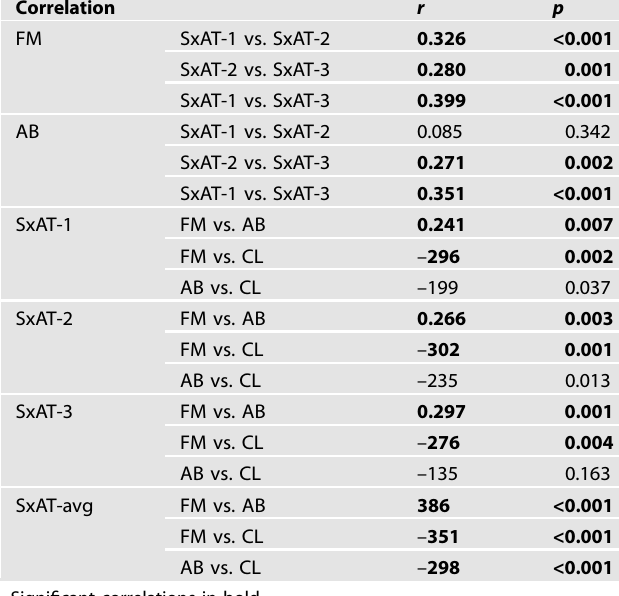
Table 1. Overview of Pearson ’ s correlation coef fi cients between the different behaviors (CL, FM, AB) in each of the three consecutive daily SxAT, or the average over all three SxAT. Correlation